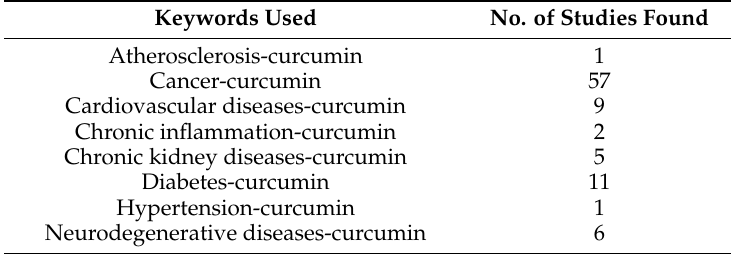
Table 4. Number of clinical trials generated from the “https://clinicaltrials.gov” database using the keywords (curcumin and the different aging-associated diseases). Keywords